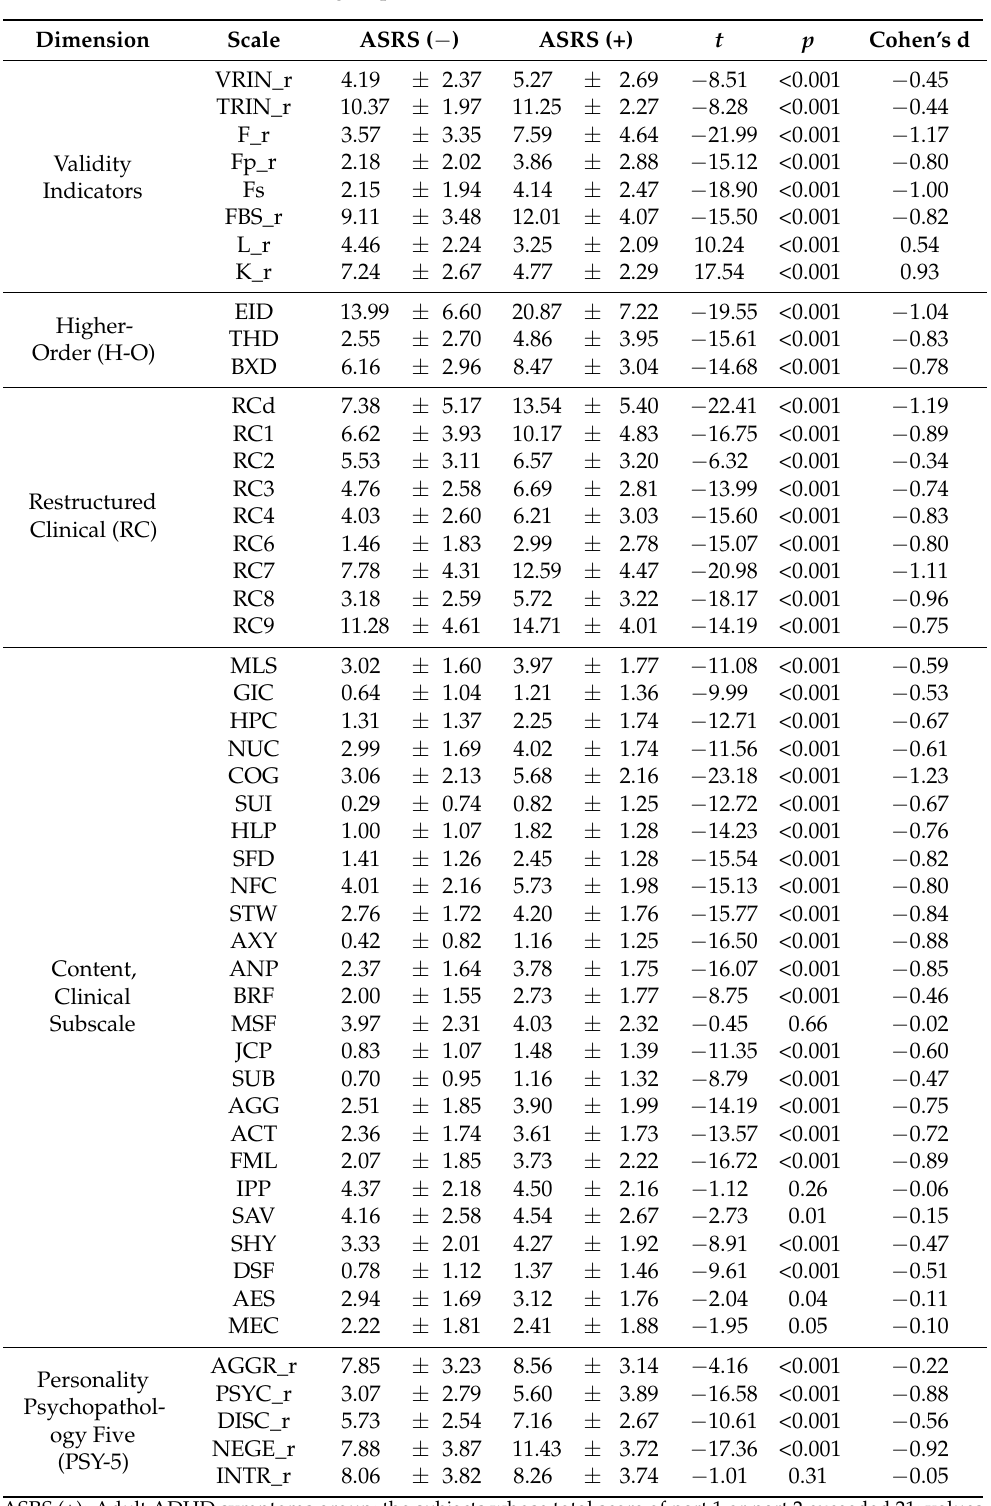
Table 1. The differences between